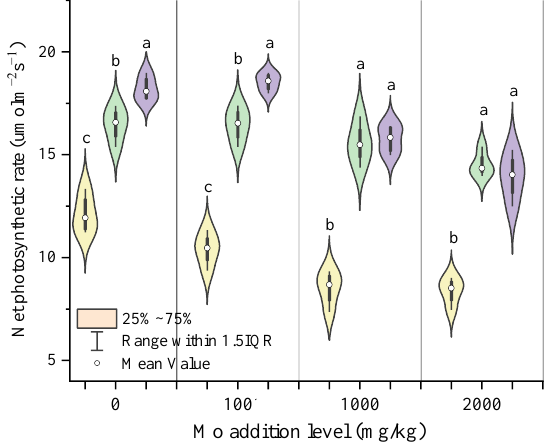
Figure 4. Net photosynthetic rate of maize at different Mo addition levels. Different lowercase letters above the bars indicate significant differences under the different in-oculation conditions at the same level of Mo addition, determined using a one-way ANOVA fol-lowed by Duncan’s multiple range test ( p < 0.05). Table 1. Chlorophyll content of maize leaf at different Mo addition and significance levels ( F values) of Mo, AMF, and their interactions on measured variables by a two-way analysis of variance.